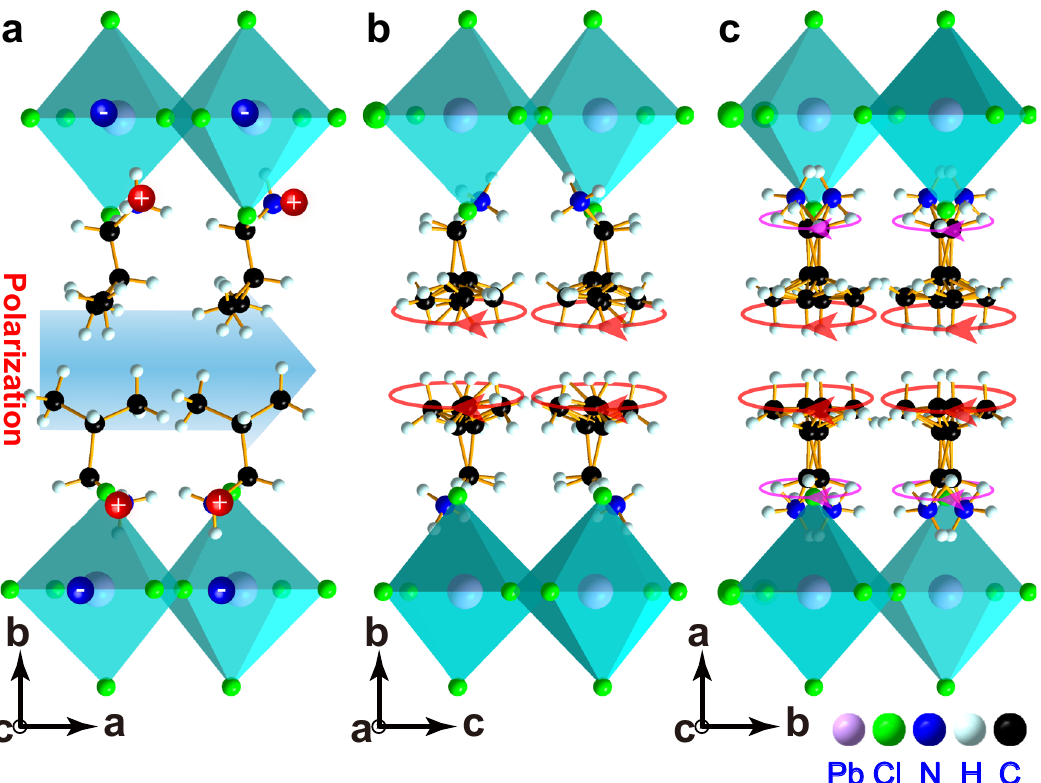
Fig. 1 Illustration of phase transitions of 1. a Monoclinic phase at 285 K. b Orthorhombic phase at 318 K. c Orthorhombic phase at 343